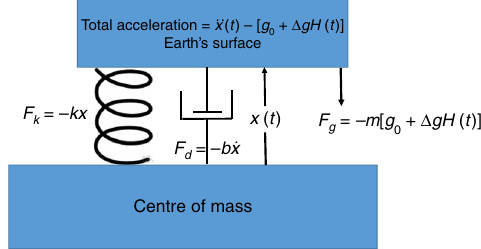
opposite to the gravity change. Considering the Tohoku earthquake, there are only two plausible length/time scales to determine this oscillation period; the fi rst is the Earth ’ s dimension (as in 0 S 0 ), and the second is the source – observer distance. For the Tohoku earthquake, the travel time of elastic deformations between the source and observer seems to be the natural scale. I speculate that the effective period will be on the order of 500 s, which is four times the S-wave travel time. Q S for this defor- mation may be about 500. That is, I hypothesize that the net acceleration on a gravimeter is approximately